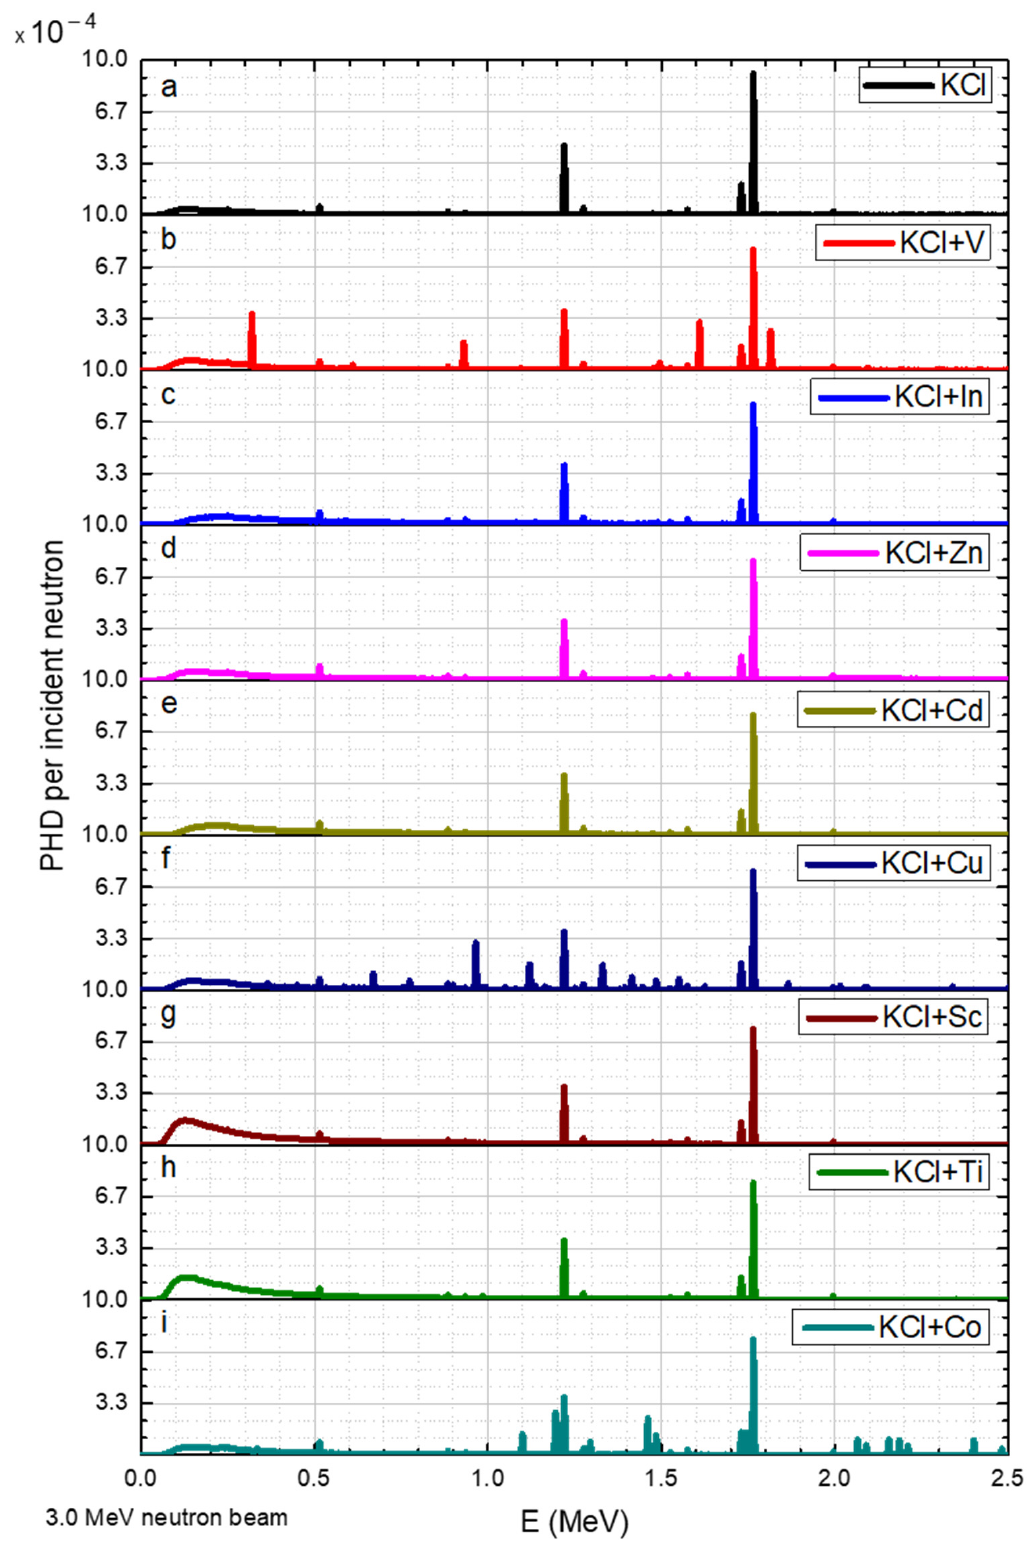
Figure 9. 3.0 MeV radiation of neutrons on KCL salt and its elements, where the y axis is the gamma pulse height distribution (PHD) per incident neutron obtained in the detector and the x axis is the gamma radiation energy. The data corresponds to a range of elements ( a – i ) added to the KCl.